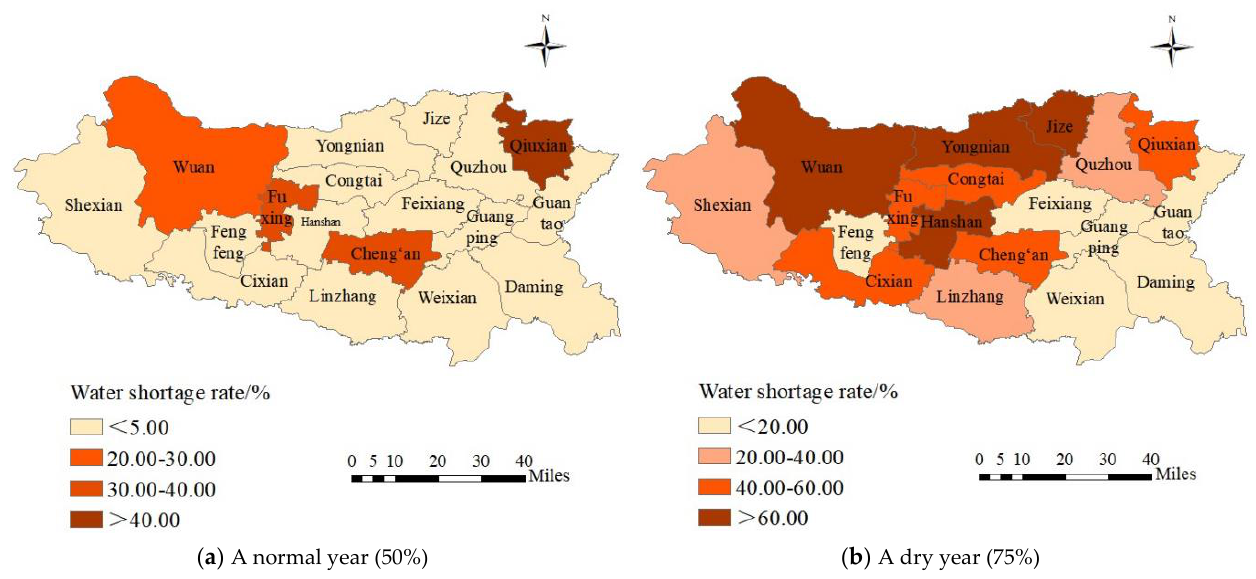
Figure 13. Agricultural water shortage in 2025.